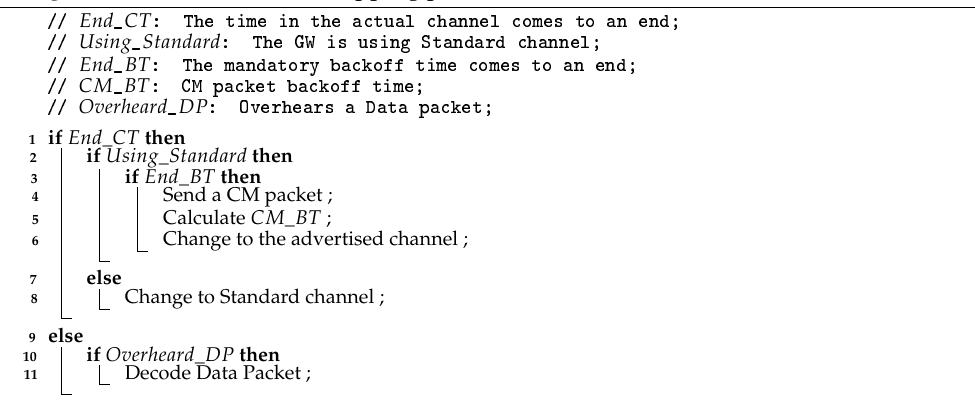
Algorithm 1: LoRa channel hopping protocol: GW execution